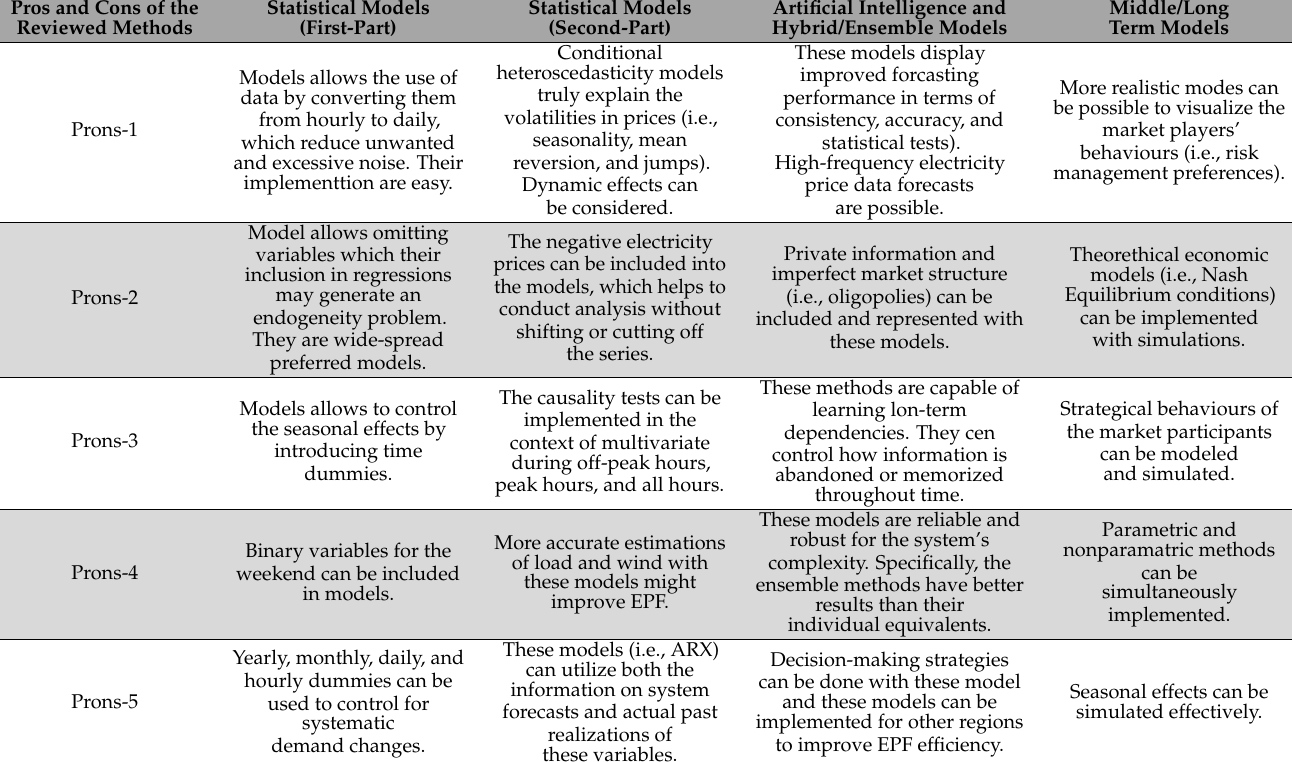
Table 6. Main pros and cons of the reviewed methods based on the references in Tables